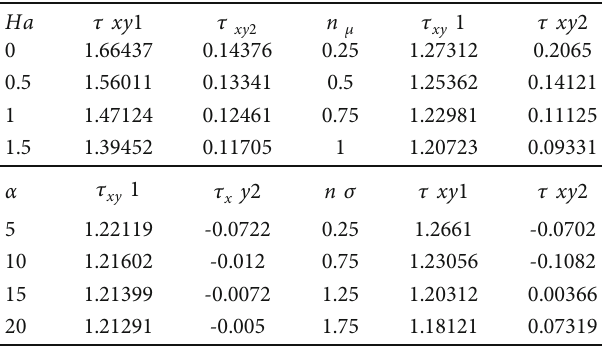
Table 3: Variation of shear wall stress with Hartmann number ( Ha ), viscosity ratio ( n μ ), slip parameter ( α ) and conductivity ratio ( n σ ) at the lower plate ð τ xy 1 Þ and at the upper plate ð τ xy 2 Þ .